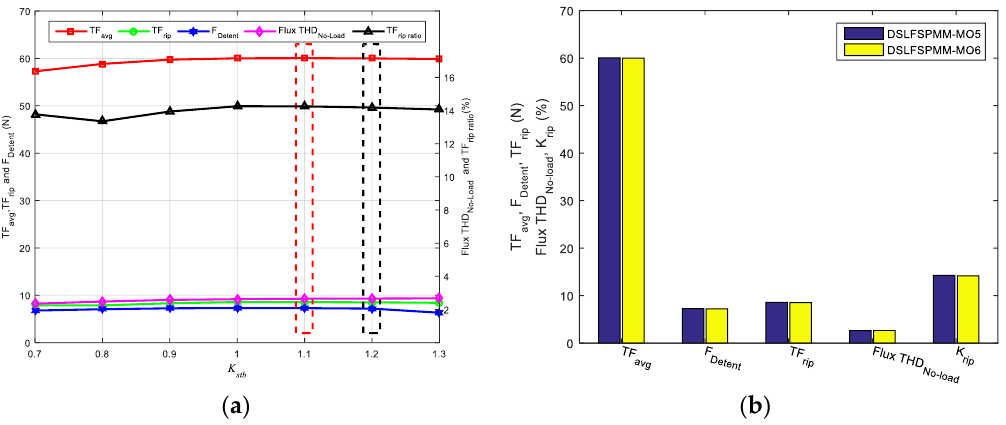
Figure 18. Stator tooth base width optimization: ( a ) Performance comparison of DSLFSPMM-MO5 having different 𝐾 𝑠𝑡𝑏 values; ( b ) Performance comparison of DSLFSPMM-MO5 and DSLFSPMM- MO6.